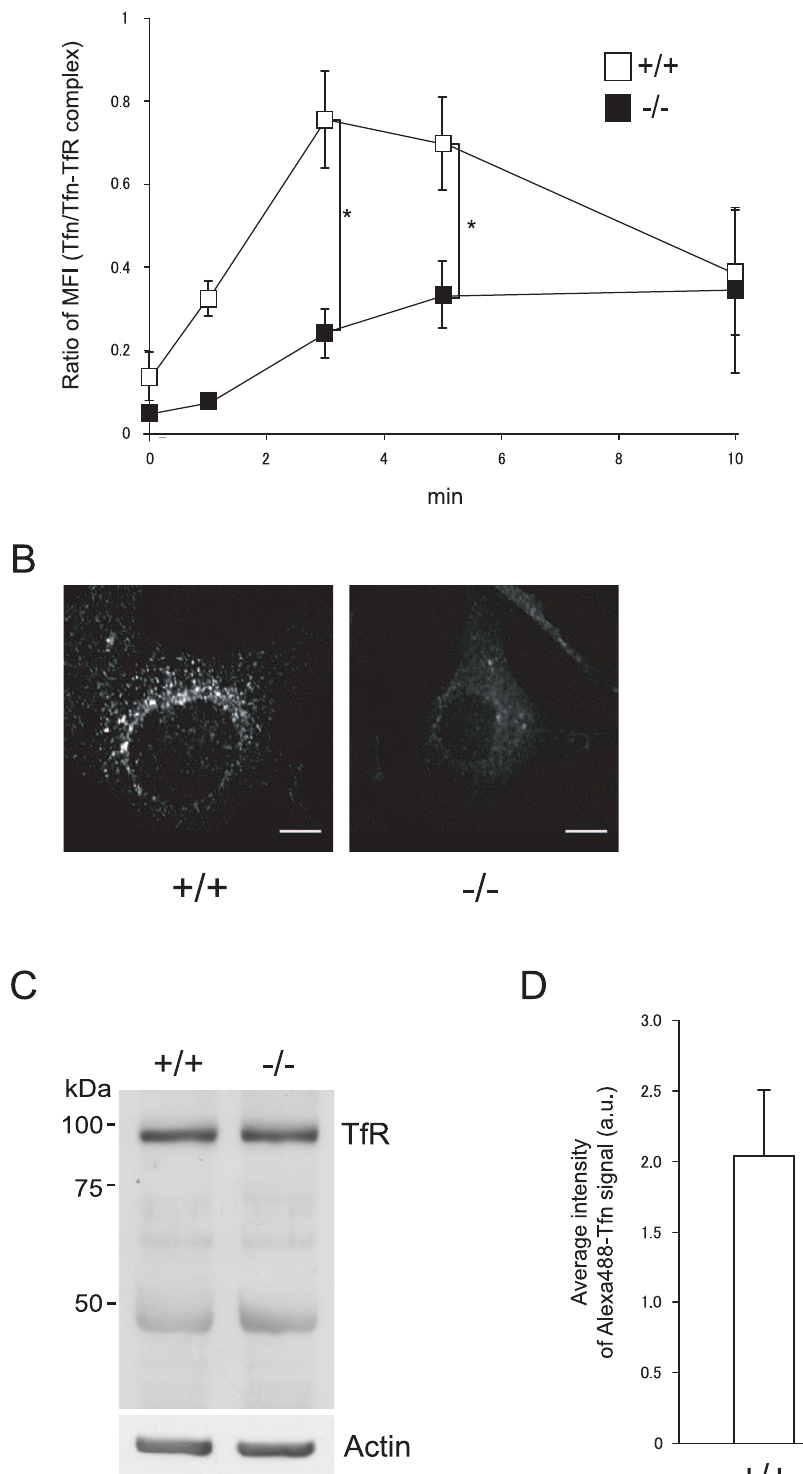
Figure 6. Impaired transferrin internalization in CALM -deficient erythroid cells and MEFs. (A) Uptake of transferrin in wild-type or CALM - deficient erythroid cells. Single cell suspensions from fetal livers were analyzed as described in Materials and Methods. Transferrin uptake was normalized to the ratio of mean anti-CD71 (transferrin receptor 1) fluorescence intensity between wild-type and CALM -deficient cells to control for